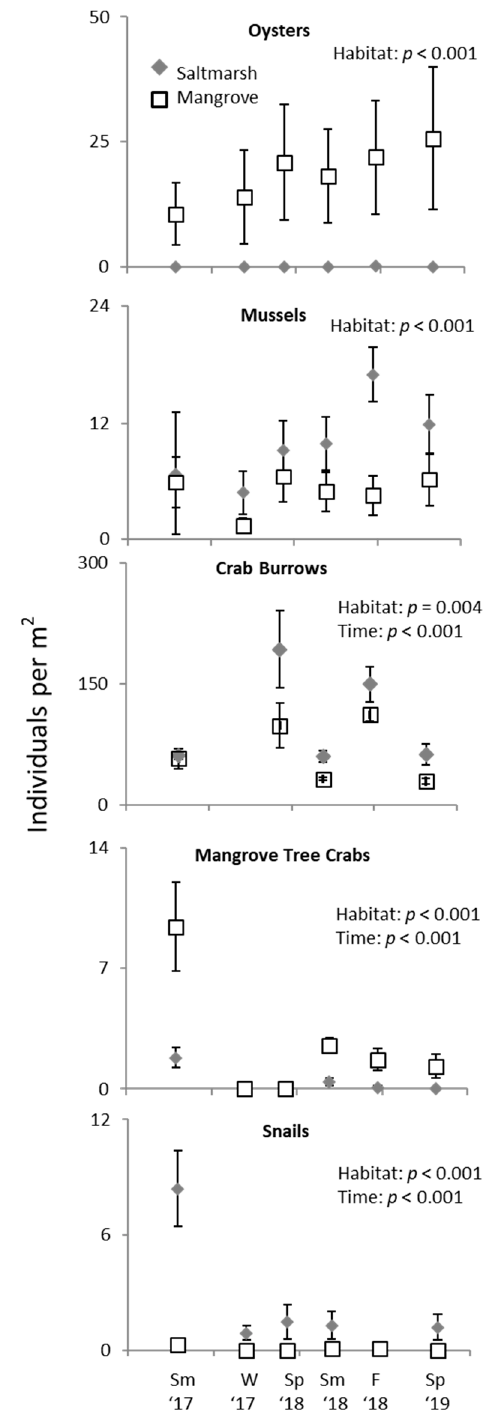
Figure 4. Invertebrate densities over time during the two-year predator exclusion experiment. Significant results are displayed in the inset panels. Since there was no treatment effect, data from control and predator exclusion plots were combined. Data are shown as the mean ± SEM for 10 replicate plots per habitat type.